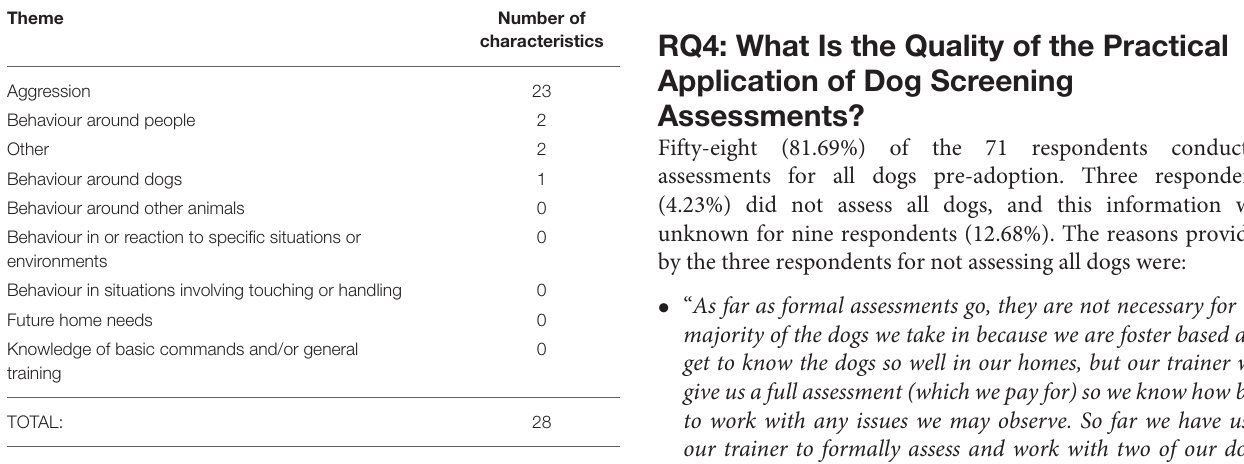
TABLE 3 | Number of characteristics that would lead a dog to be deemed unadoptable by theme.